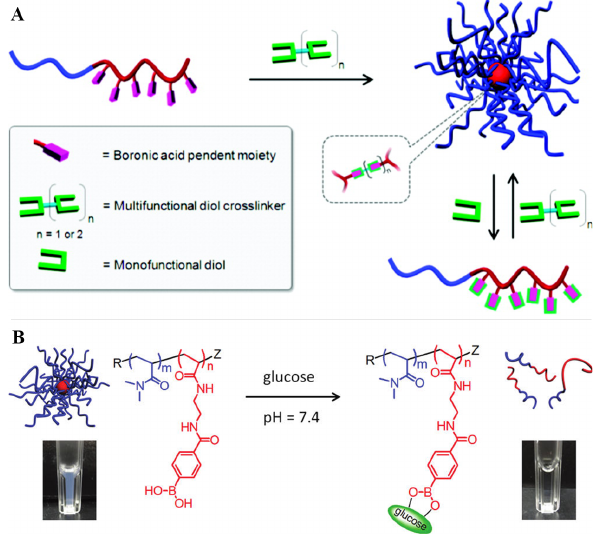
Figure 1: (A) Formation and disintegration of dynamic-covalent nanoaggregates via boronic ester linkages. Reprinted with per- mission from [25]. Copyright 2011, American Chemical Society. (B) Schematic illustration for glucose-triggered dissociation of the nanoparticles. Reprinted with permission from [26]. Copyright